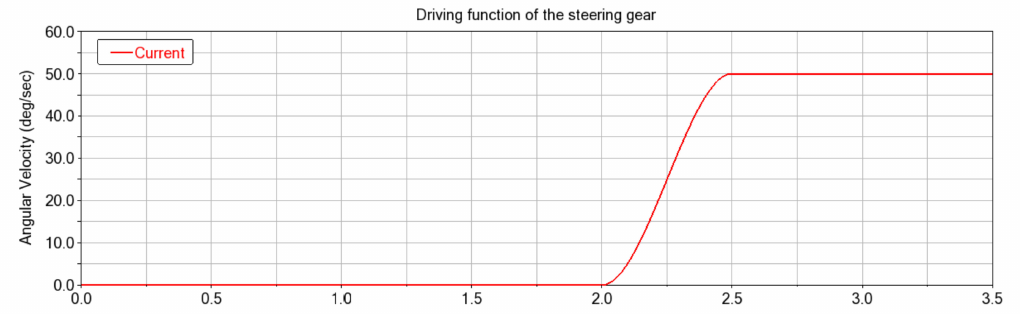
Figure 12. Servo drive function curve. The motor is driven by angular velocity. The x-axis and y-axis represent time and angular velocity, respectively. The angular velocity of the steering gear increases from 0 ◦ /s to 50 ◦ /s within 5